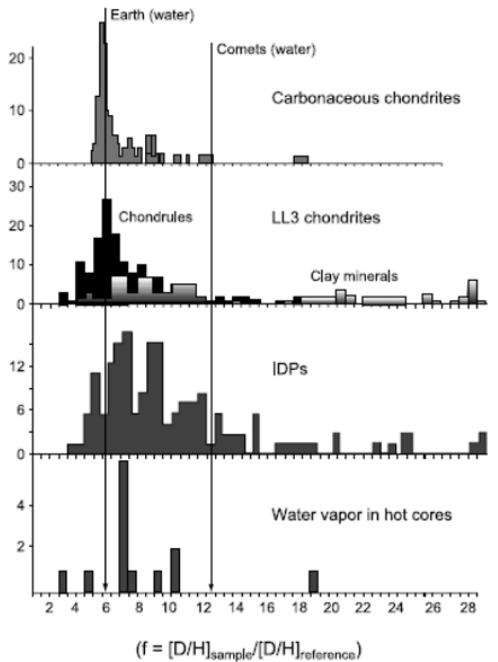
Figure 11. Distribution of D/H ratio in carbonaceous chondrites (whole rock), LL3 ordinary chondrites, IDPs and water in hot cores, from [131]. f is used to normalize the ratios to a reference, which is D / H = 25 × 10 − 6 for meteorites and IDPs (solar nebula) and 16 × 10 − 6 for hot cores (interstellar). Vertical lines indicate the values for terrestrial and cometary water. Note the large heterogeneity in the distribution of D/H ratios, reflecting complex processes prior accretion of the parent